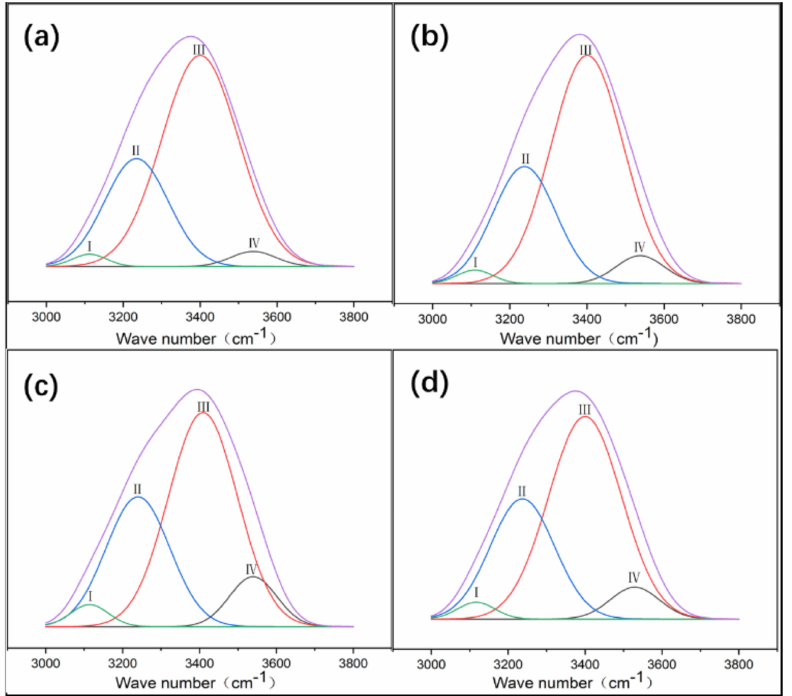
Figure 3. Gaussian curve fitting of different types of hydrogen bonds of PVA/NC nanofibers with different NC content to composite materials. ( a ) The proportion of different types of hydrogen bonds in NC2 nanofibers. ( b ) The proportion of different types of hydrogen bonds in NC4 nanofibers. ( c ) The proportion of different types of hydrogen bonds in NC6 nanofibers. ( d ) The proportion of different types of hydrogen bonds in NC8